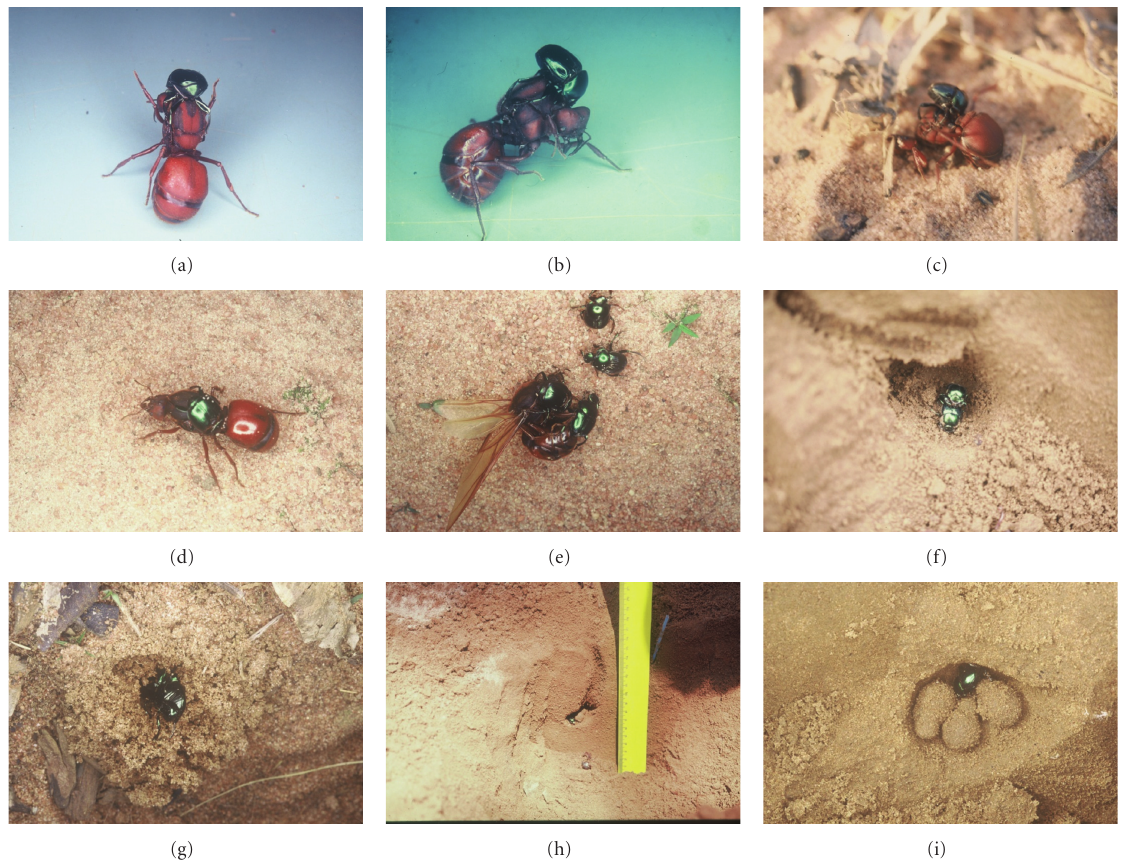
Figure 2: (a) A beetle flies zigzag over prey and lands on its back. (b) The beetle cuts the neck of the queen and is attached to it by its legs. (c) The queen has been killed: the beetle examines the prey, before rolling it. (d) Sometimes the beetle may attach itself to the thorax of the queen, having the head turned toward the queen abdomen. (e) When the queen is dead, many other beetles may join. (f) After a few minutes only two beetles remain to bury the queen. (g) The beetle is partially buried and has its abdomen and hind legs facing up and is partially buried; this phenomenon is observed when the beetle buries its prey by itself. (h) The nest of Canthon virens , with a channel about 1cm in diameter and 15cm deep. (i) Chamber at the end of the canal, with the brood balls.